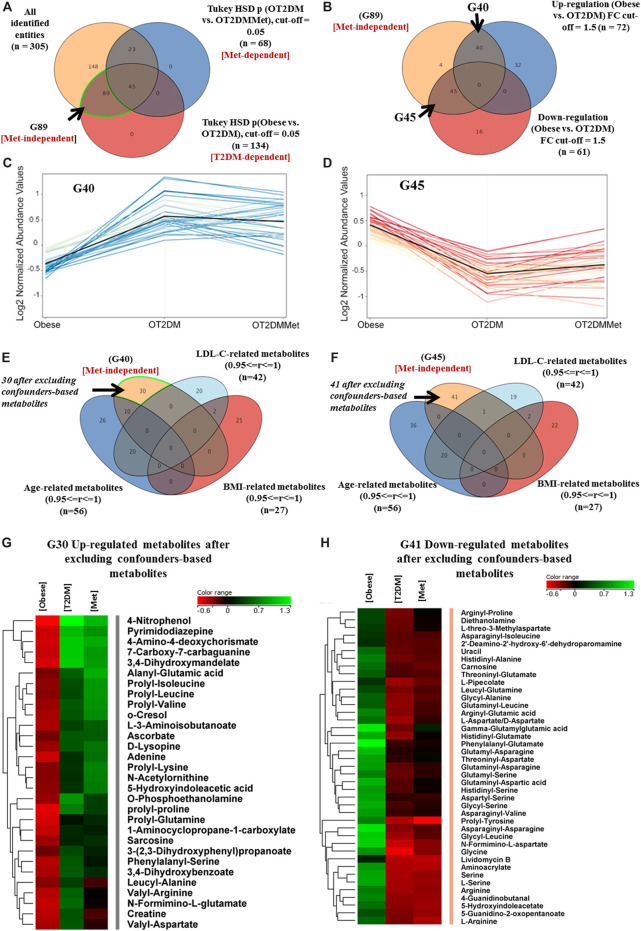
Metabolic pattern of T2DM effect on metabolites that are irresponsive to metformin administration in obesity (A) Venn diagram illustrates the extraction of 89 metabolite (G89) that were significantly dysregulated due to diabetes but not metformin effect (metformin-independent) (B) Venn diagram shows the breakdown of the G89 (Met-independent) after applying the fold change cutoff 1.5, where 40 and 45 metabolites were up and downregulated in diabetes, respectively (C) 40 (G40) metabolites were up regulated as of T2DM and their levels were unchanged after metformin administration (D) 45 (G45) metabolites were down regulated as of T2DM and their levels were unchanged after metformin administration (E, F) Venn diagrams demonstrate the exclusion of the confounders-based metabolites from G40 and G45, which were reduced to G30 and G41, respectively (G, H) Heat maps of the identified features (G30 and G41) that were either upregulated or down regulated, respectively, after excluding the confounder-based metabolites as of T2DM effect in obesity.